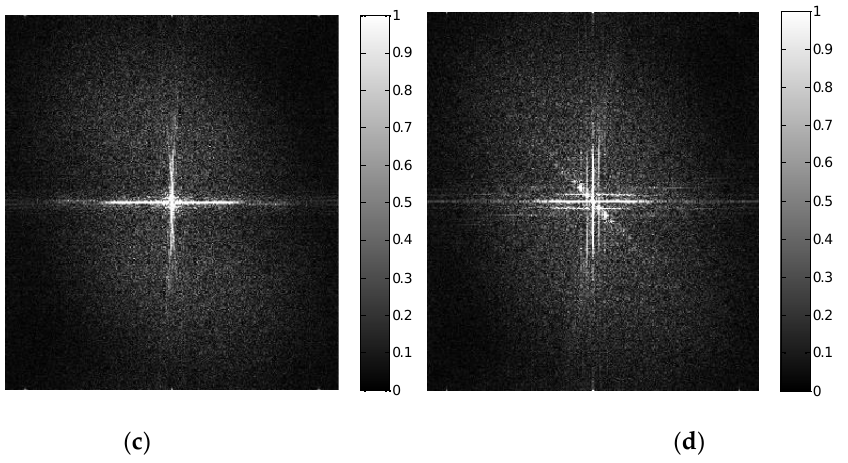
Figure 8. Microscopic morphology and frequency-domain analysis with A and B parameters. ( a ) Micromorphology at A point, ( b ) Micromorphology at B point, ( c ) 2DFFT at A point, ( d ) 2DFFT at B point.